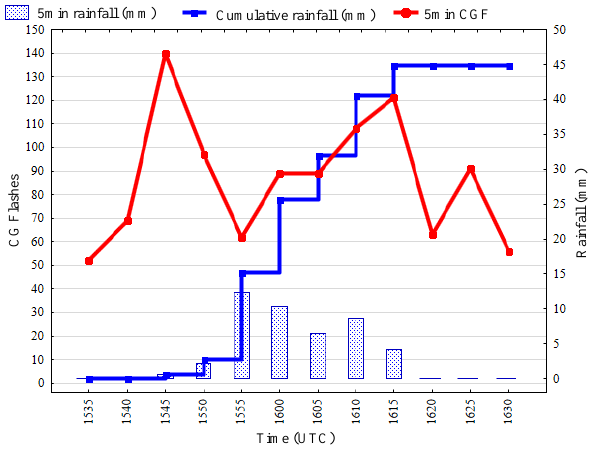
Figure 15. Critical interval time series for debris flow event of 20 September 1999. This is an event from the AL group and de- bris flow initiation was observed at